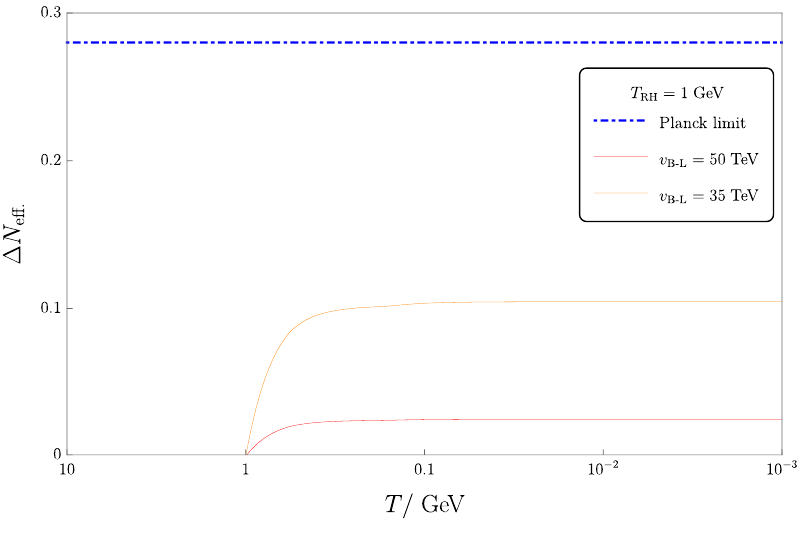
Figure 6 . ∆ N eff. as a function of temperature for fixed T RH and two different v B-L .